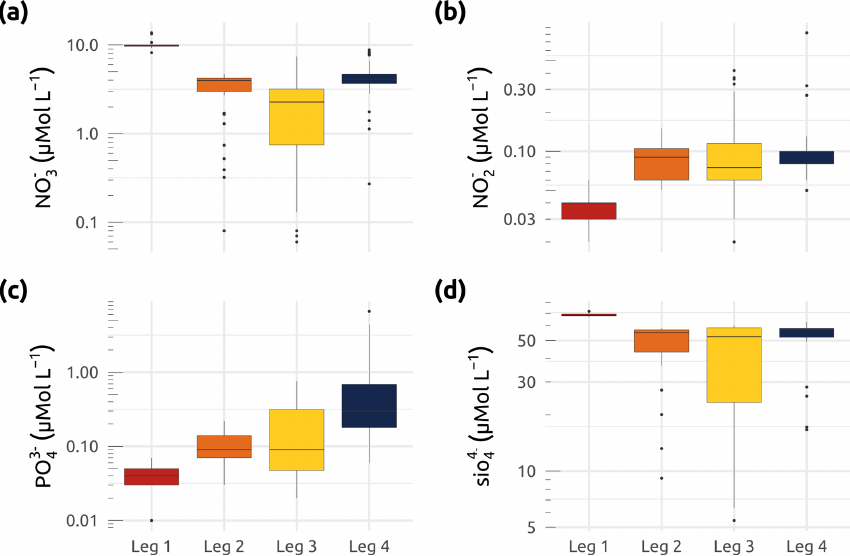
− ), (b) nitrite (NO − ), (c) phosphate (PO 3 − ), and (d) silicate 3 2 4